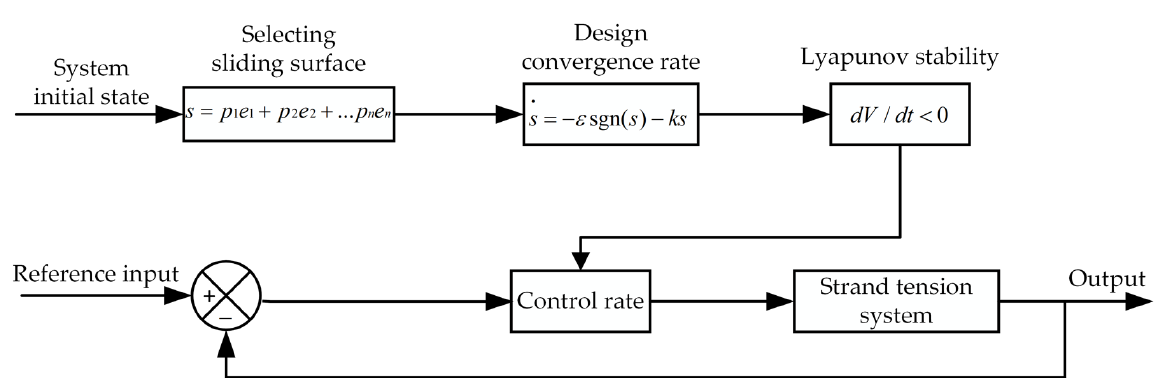
Figure 10. Design of discrete sliding mode controller.